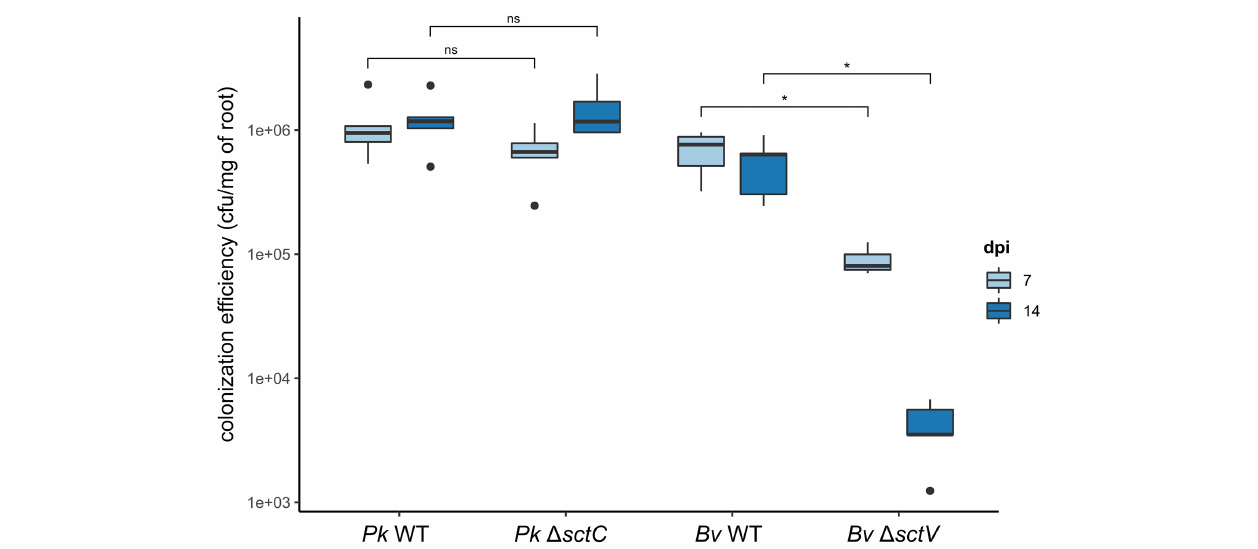
FIGURE 5 | Effect of T3SS loss on root colonization by B. vietnamiensis LMG10929 and P. kururiensis M130. Rice seedlings were inoculated with either WT or T3SS deficient strains of P. kururiensis M130 or B. vietnamiensis LMG10929 and the roots were harvested at 7 and 14 dpi, homogenized and the colonizing bacteria population estimated using serial dilutions and spot counting. Cfu/mg of roots were compared between conditions with a Wilcoxon test (* p < 0.01; ns, not significant). Black dots represent outgrouping samples. Mock inoculations were conducted on a control set of plants which showed a complete absence of developing bacteria at both